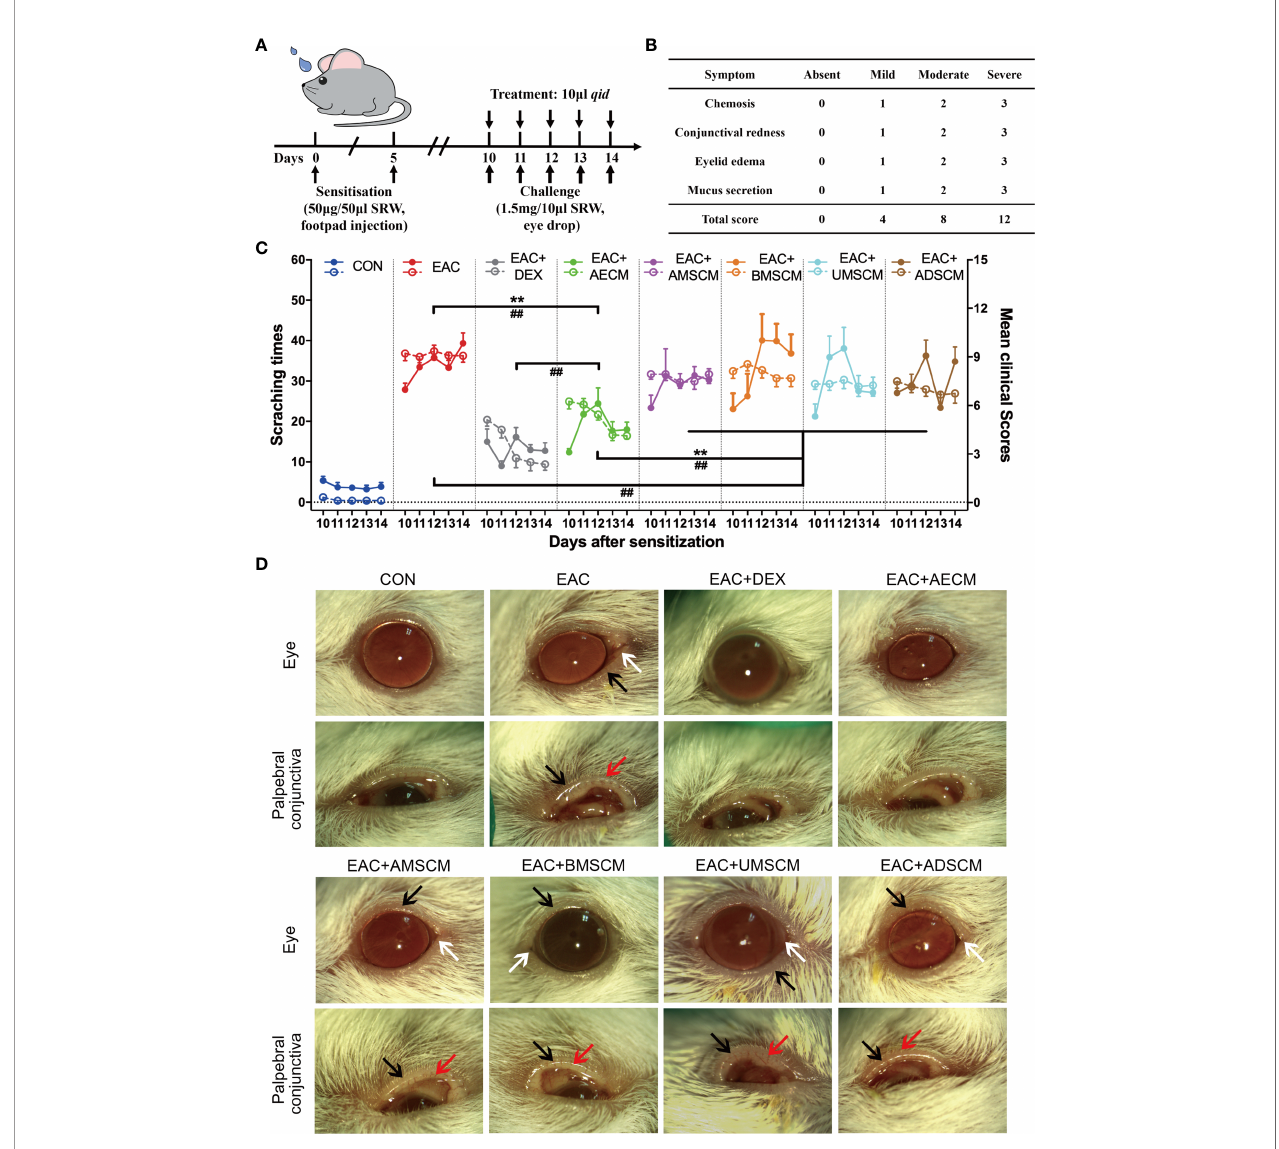
FIGURE 1 | Comparison of the therapeutic effects of the TSC-CM on EAC mice. (A) A schematic illustration of the experimental design. Mice were fi rst immunized with 5 m l SRW solution at day 0 and day 5, then challenged with 10 m l SRW solution daily from day 10 to day 14. At the same time, the mice were pretreated with 10 m l TSC-CM four times per day. (B) Clinical score was used to evaluate the severity of chemosis, conjunctival redness, eyelid edema, and mucus secretion under slit lamp. (C) The times of scratching response (left Y axis, solid points) and clinical scores (right Y axis, hollow points) of the severity of EAC symptoms were evaluated at the indicated time points after challenge with SRW solution in different groups. CON represents the normal control mice pretreated with DMEM/F12 medium without SRW pollen treatment. Solid points represent the times of scratching response. Hollow points represent clinical scores. The data are expressed as mean ± SEM, n = 8. ** P < 0.01 in scratching times. ## P < 0.01 in clinical scores. (D) Representative images of ocular symptoms in each group photographed by slit lamp microscopy 24 h after the last challenge. White arrows represent chemosis, red arrows represent conjunctival redness, and black arrows represent eyelid